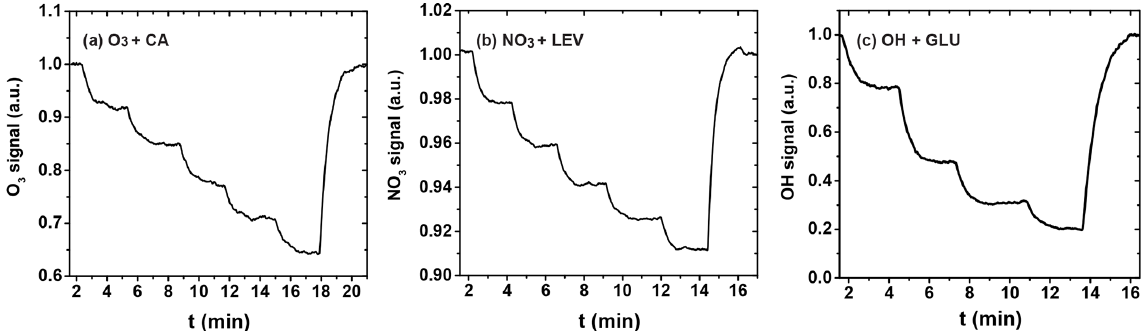
Figure 5. Reactive uptake experiments showing the change in the normalized gas-phase oxidant signal as the reaction time is changed by pulling back the injector incrementally. (a) Uptake of O 3 by canola oil (CA); (b) uptake of NO 3 by levoglucosan (LEV); (c) uptake of OH radical by glucose